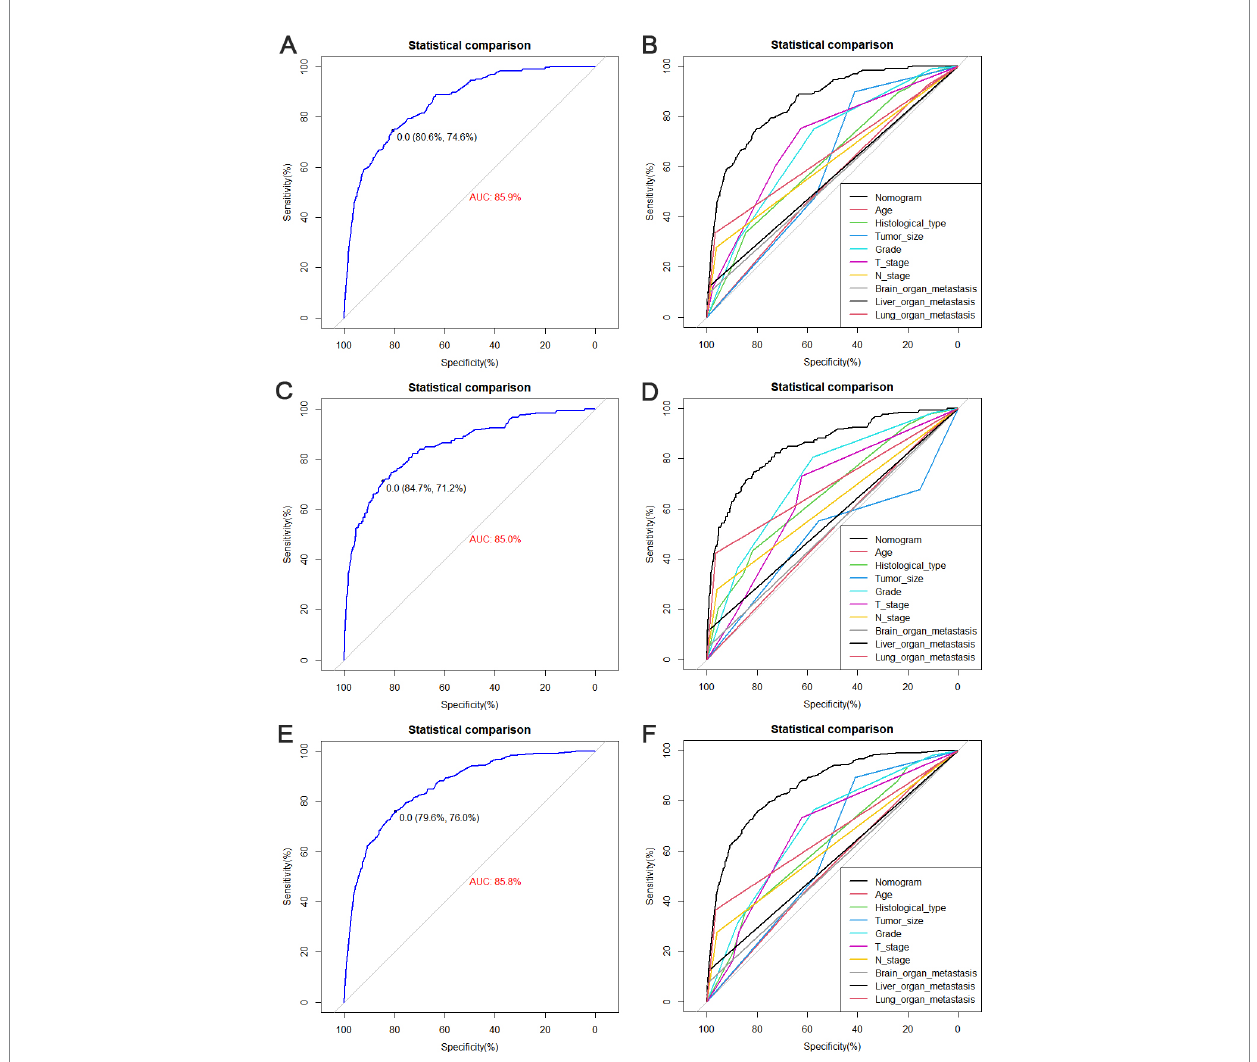
FIGURE 5 Receiver operating characteristic (ROC) curves for the training set (A) , the validation set (C) , and the extended validation set (E) . Comparison of nomograms and the area under curve (AUC) of all predictors in the training set (B) , validation set (D) , and extended validation set (F)